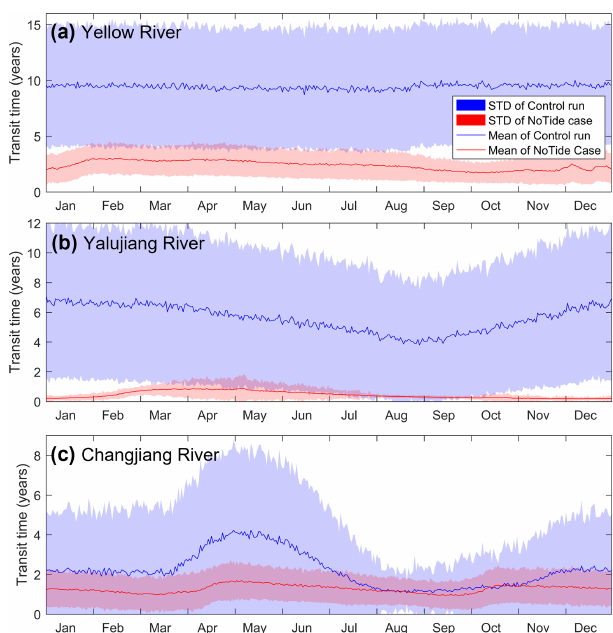
Figure 4. The daily mean water transit time over the shelf of the three rivers for the control run (blue) and no-tide case (red). SD in the figure label denotes the standard deviation of the transit time for particles released on the same